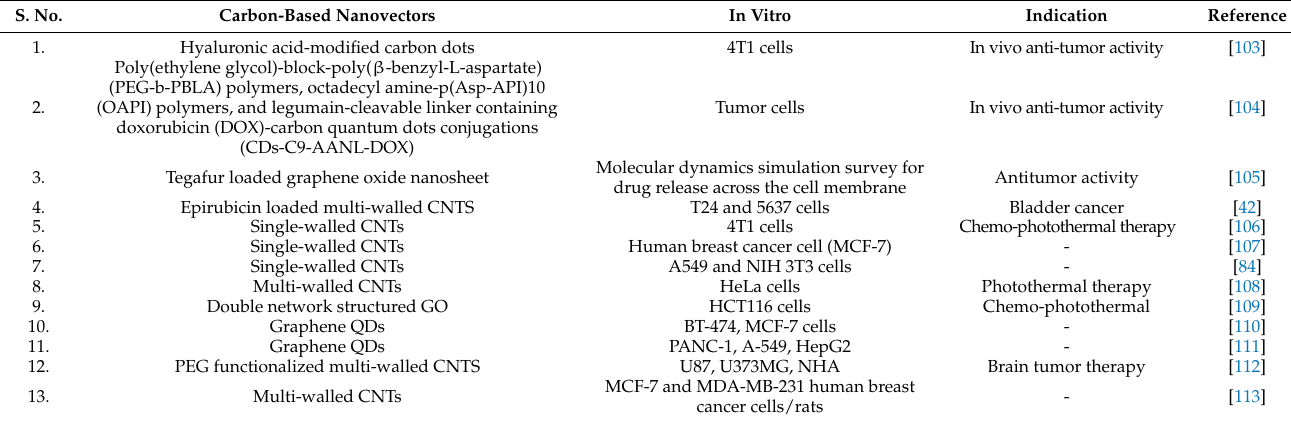
Table 3. Various carbon nanovectors used in the treatment of